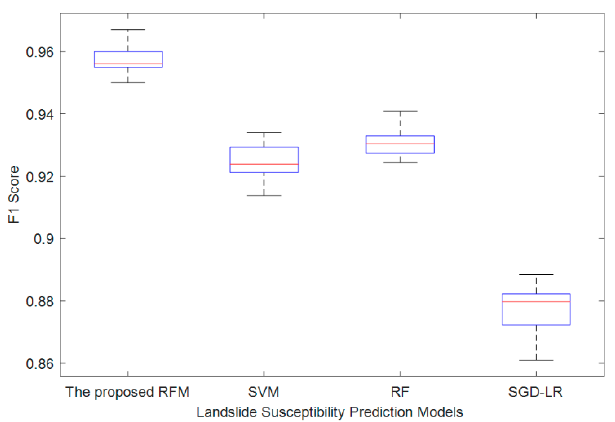
Figure 9. Model performances obtained from the repetitive data sampling process.